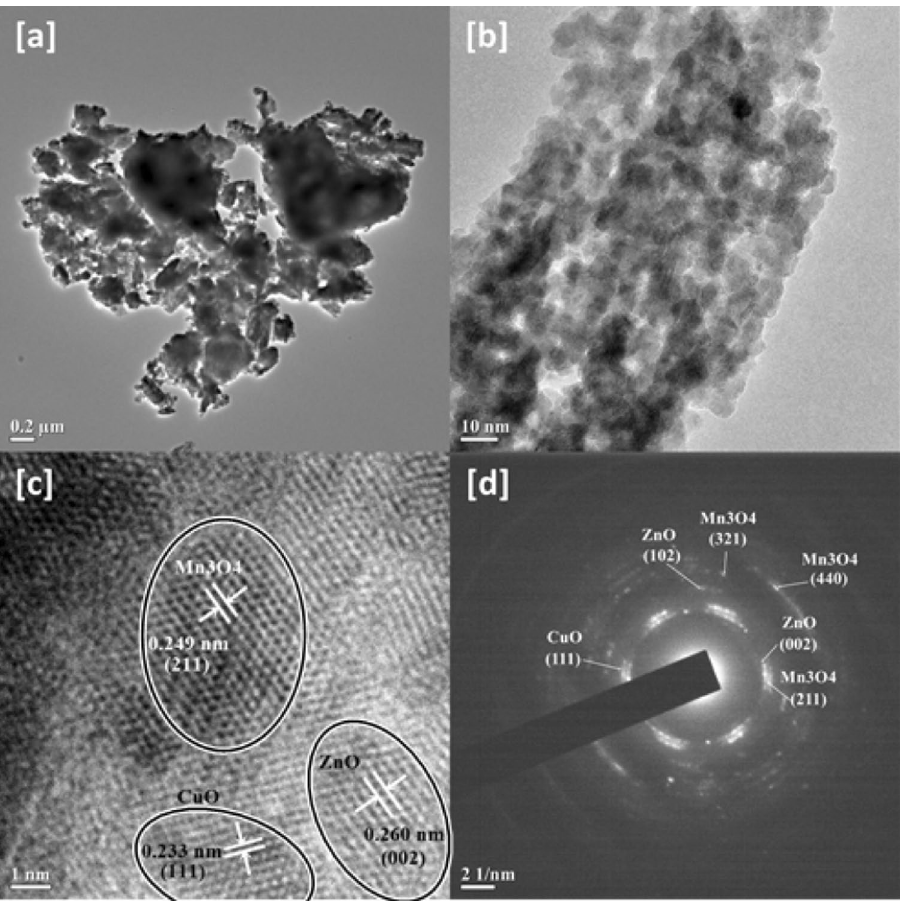
Figure 2. ( a ) TEM micrograph, ( b , c ) HRTEM micrographs and ( d ) SAED patterns of CuO/Mn 3 O 4